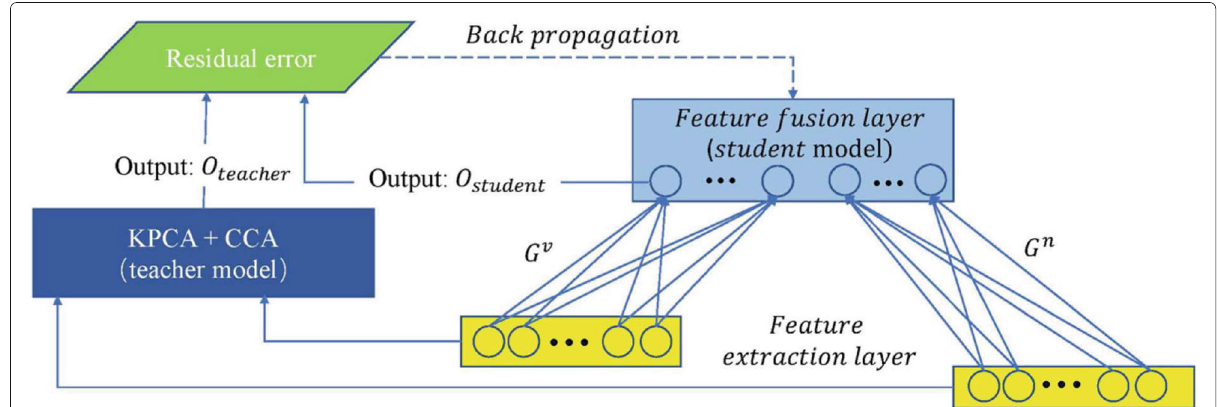
Fig. 2 The flowchart of FFKD method. The teacher model consists the KPCA and CCA modules; the student model is an one-layer perceptron. The FFKD methods is proposed to transfer the knowledge from the teacher to the student